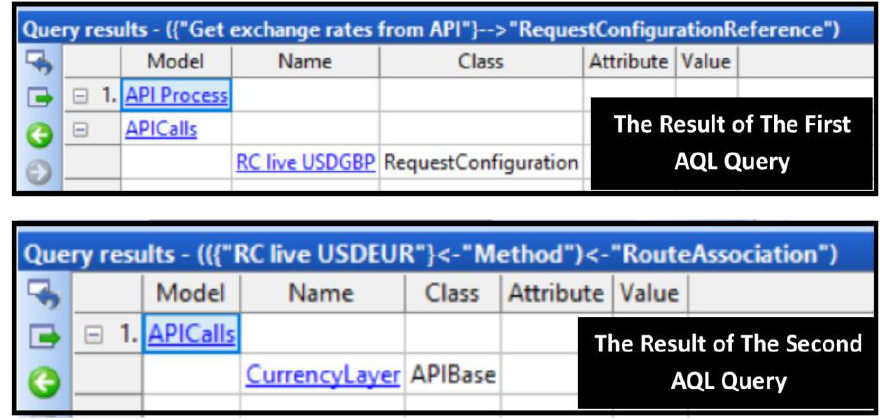
Figure 12 . AQL query examples